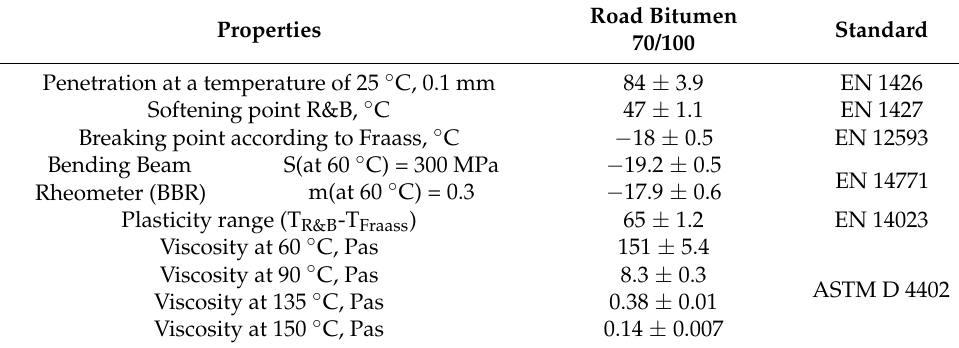
Table 3. Test results of the